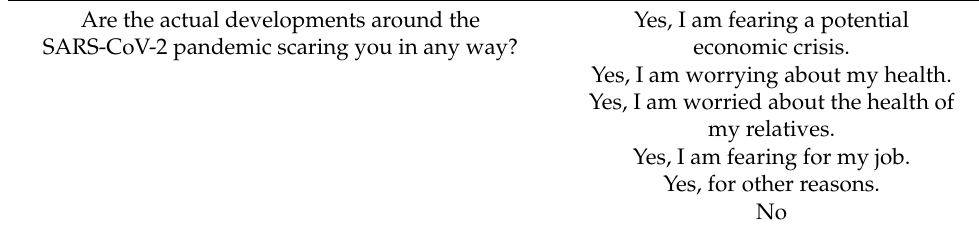
Table 1. Self-constructed COVID-19 work-related fears questionnaire. Are the actual developments around